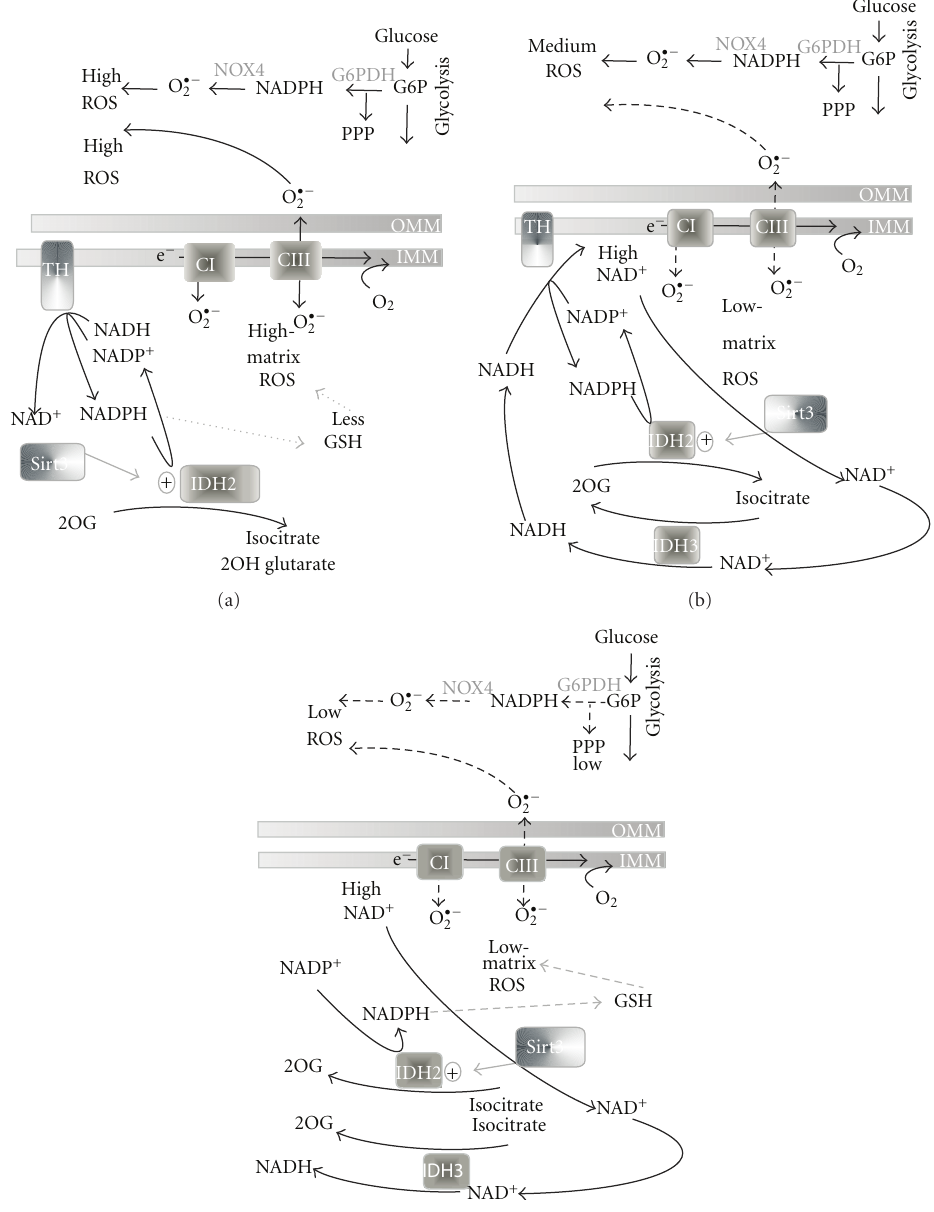
Figure 2: Consequences of IDH2 functions for redox homeostasis in cancer cells and nonmalignant cells.